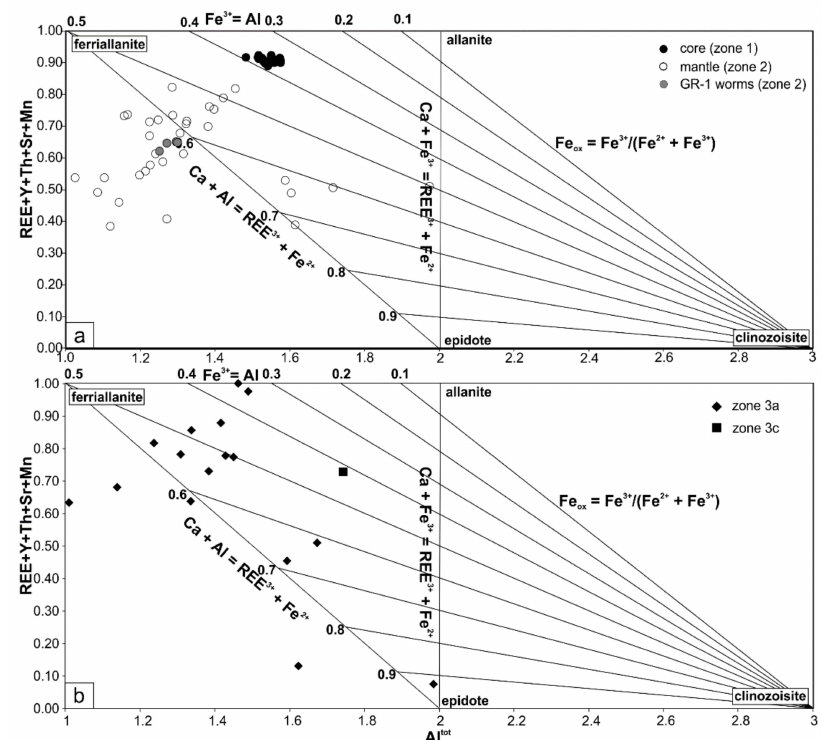
Figure 5. Cationic Al tot vs. REE + Y + Th + Sr + Mn plot after Petrik et al. [2], showing the position of the studied allanites in the ferriallanite–allanite–epidote–clinozoisite system. The isolines represent Fe ox = Fe 3 + / (Fe 2 + + Fe 3 + ) ratio. ( a ) Zones 1 and 2 for Gruszk ó w and Sokoliki allanites; ( b ) Zones 3a and 3c for Gruszk ó w and Sokoliki allanites.